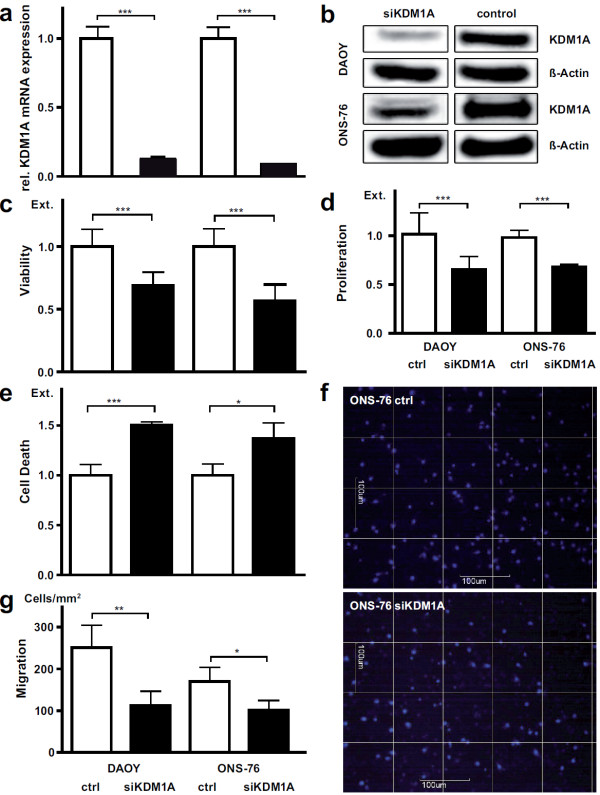
KDM1A inhibition impairs cell proliferation and migration and induces apoptosis in human medulloblastoma cell lines. a Bars represent KDM1A expression measured using real-time RT-PCR and normalized to the geometric mean of GAPDH, UBC and HPRT expression in DAOY and ONS-76 cell lines 72 h after KDM1A knockdown or mock transfection. ***p < 0.0001 b Knockdown of KDM1A protein was confirmed by western blotting of whole-cell lysates from DAOY and ONS-76 cells. β-actin served as loading control. c The DAOY and ONS-76 medulloblastoma cell lines were transfected with siRNA directed against KDMA1, and cell viability was measured using the MTT assay. Extinction relative to mock-transfected cultures at 72 h is shown. ***p < 0.0001 d Proliferation of DAOY and ONS-76 cells following mock transfection or transfection with siRNA directed against KDM1A was assessed by BrdU ELISA. Bars show extinction relative to mock-transfected cultures at 72 h. ***p < 0.0001 e Apoptosis in DAOY and ONS-76 cells was measured by Cell Death Detection ELISA™ 72 h after transfection with either siRNA directed against KDMA1 or mock transfection. Extinction is relative to mock-transfected cultures. ***p < 0.0001, *p < 0.05 f Migratory activity was assessed for the ONS-76 cell line 48 h after transfection with either siRNA directed against KDM1A or mock transfection in Boyden chamber assays. Representative images of DAPI-stained mock-transfected control cells (ONS-76 ctrl) and KDM1A-knockdown cells (ONS-76 siKDM1A) invading the membrane (scale bars = 100 μm). g Statistical analysis of results from Boyden chamber assays 24 h after DAOY and ONS-76 cells, either transfected with siRNA directed against KDM1A or mock-transfected, were plated in the upper chamber. Bars display quantity of cells per mm square which migrated through the membrane. **p < 0.01, *p < 0.05.